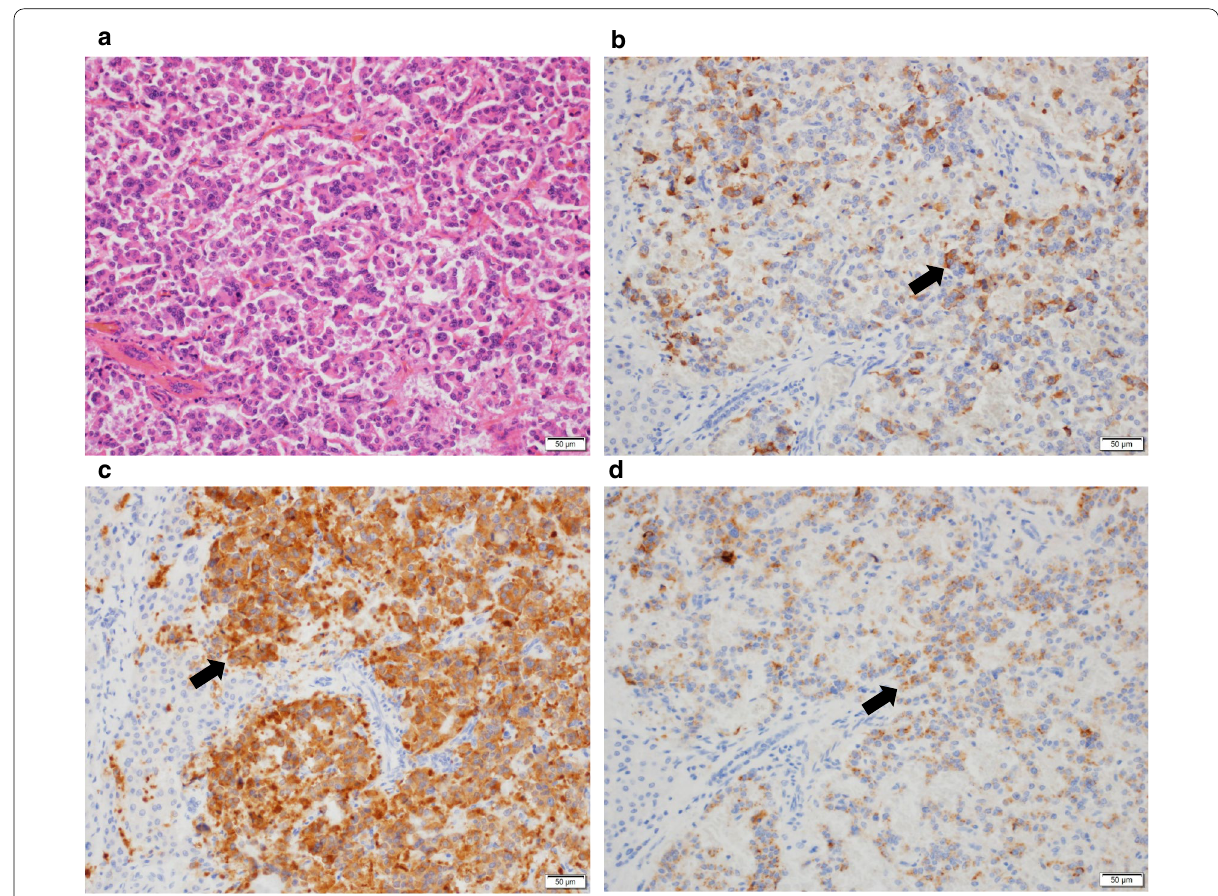
Fig. 4 Microscopic findings of the resected specimen. a Hematoxylin and eosin staining of the liver mass showed a tubular, funicular, and solid increase of small cube-shaped, atypical cells. b Immunostaining for gastrin of the liver mass was positive (arrow). c Immunostaining for synaptophysin of the liver mass was positive (arrow). d Immunostaining for chromogranin A of the liver mass was positive